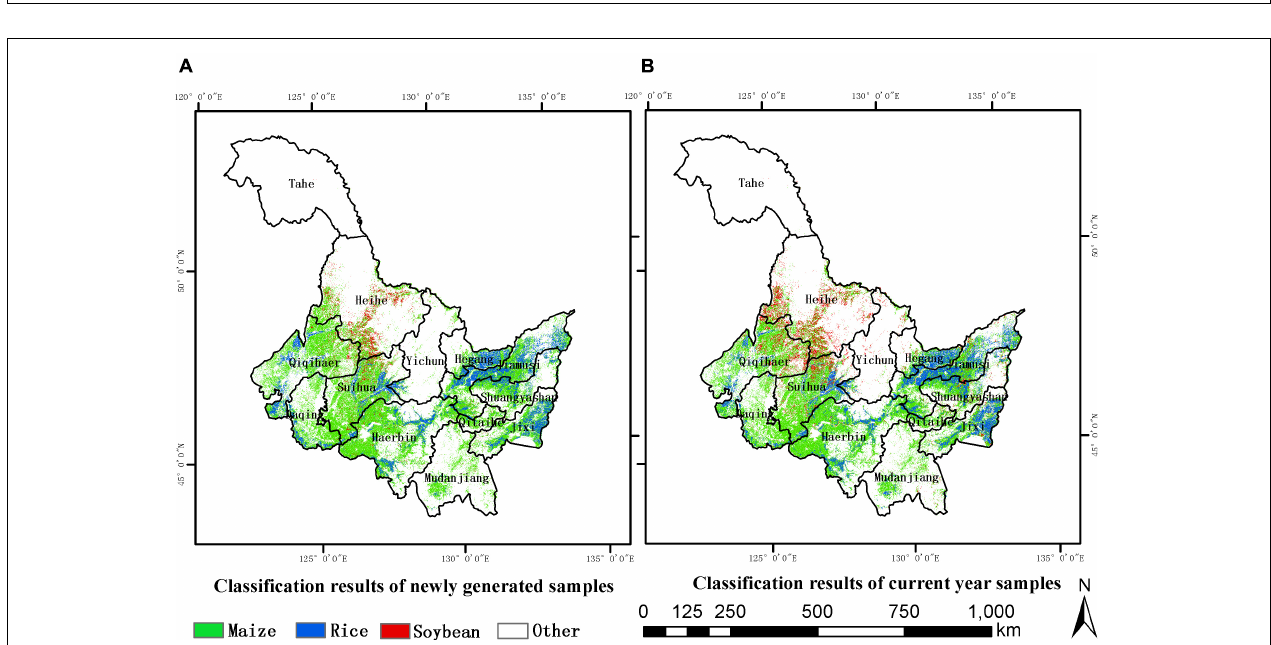
FIGURE 11 | Classification map where (A) is the result of the newly generated samples from 2013 to 2015, and (B) is the result of the samples in target year (2018).